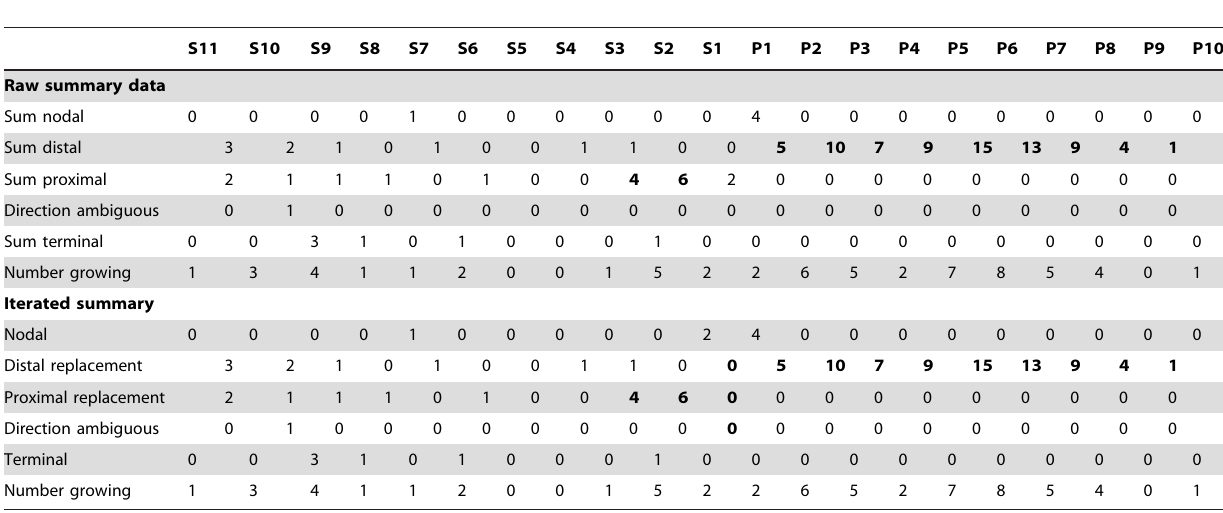
Table 1. Molt summary for primaries and secondaries in immature Hemiprocne mystacea